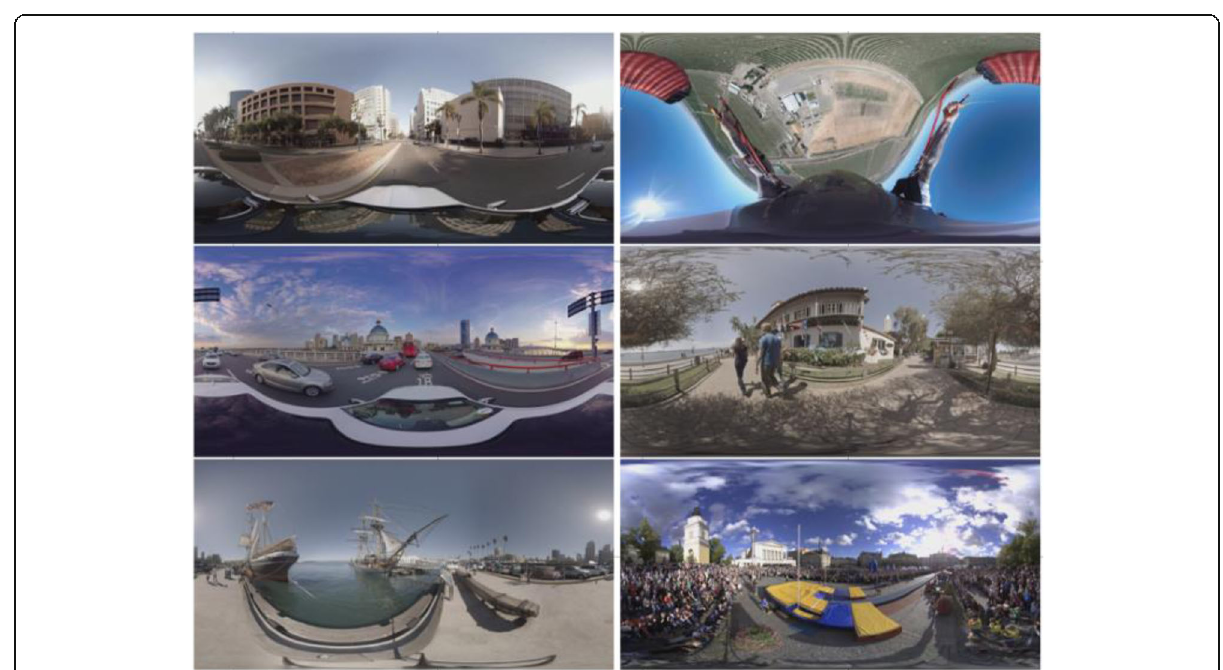
Fig. 3 Features of the upper and lower parts of 360 ERP video sequences